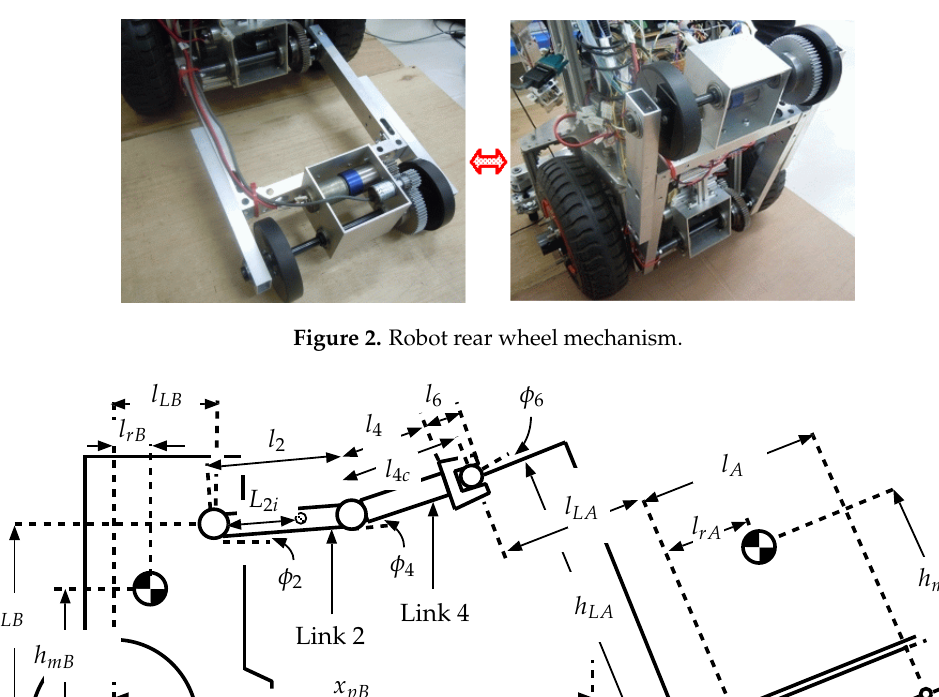
Figure 3. Model of the robot and the hand cart